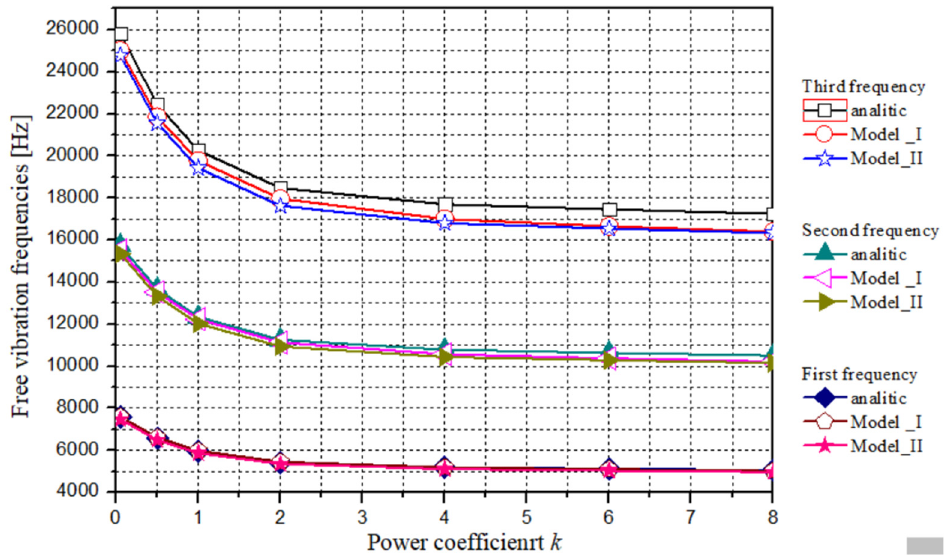
Figure 23. Compared free vibration frequencies of analyzed FGP. The shapes of the free vibration frequencies for those two models used